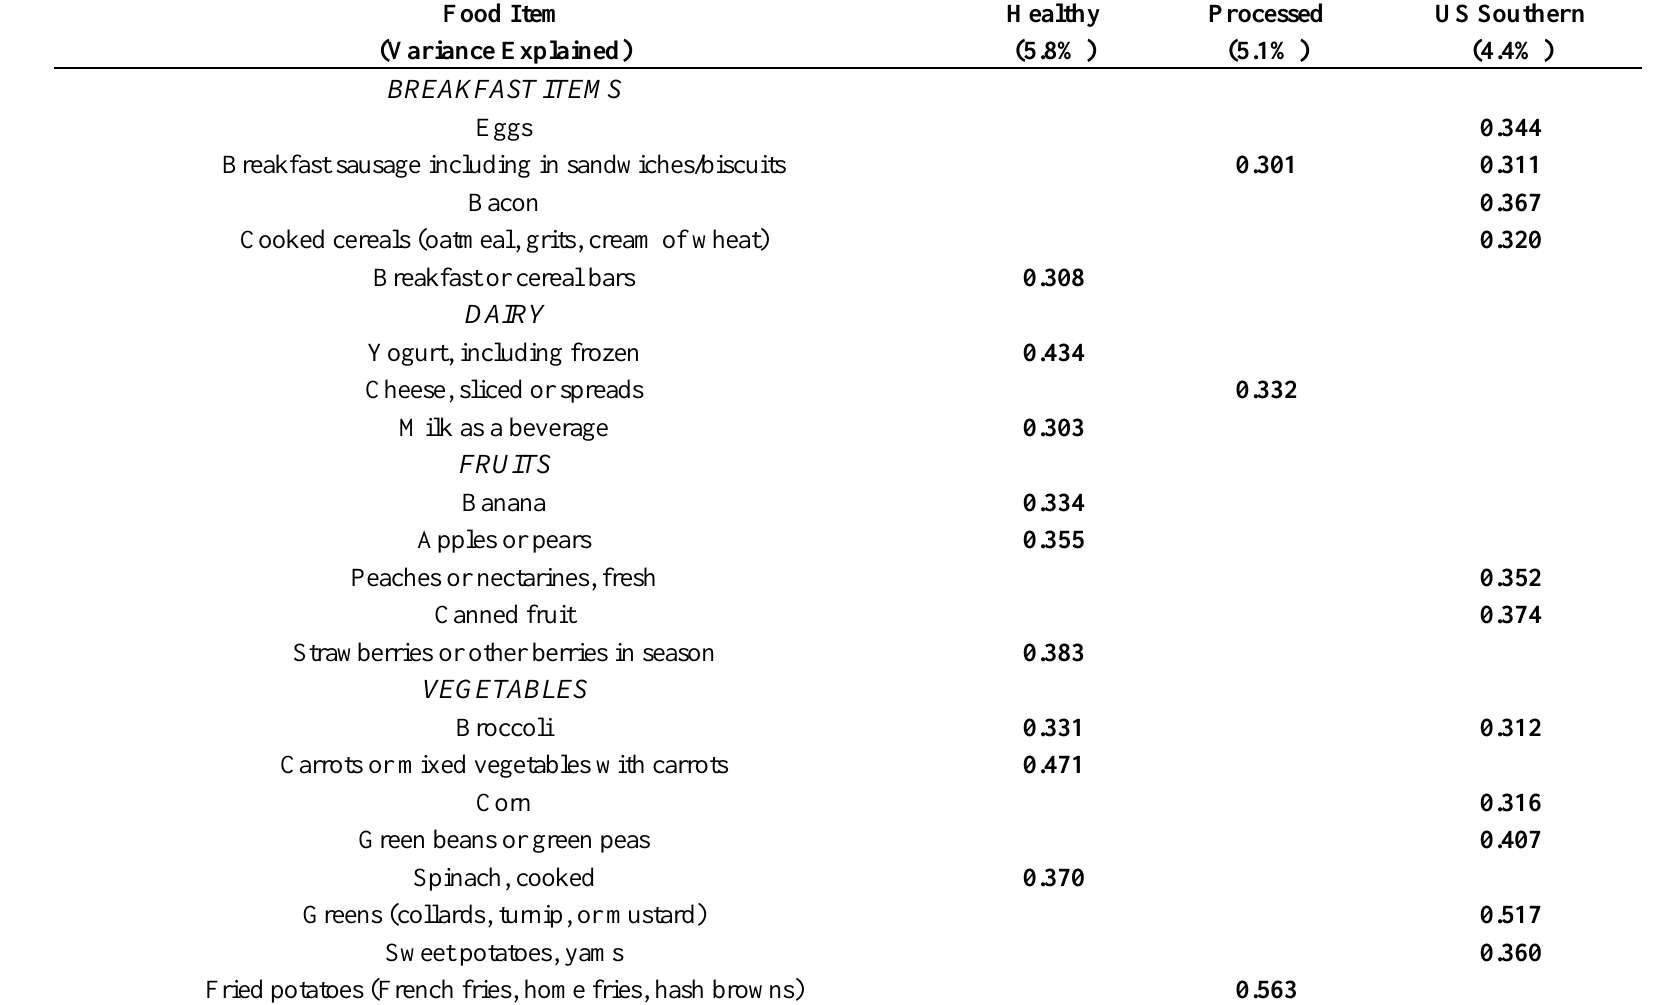
Table 1. Factor loadings of food and beverage items/groups in the three main